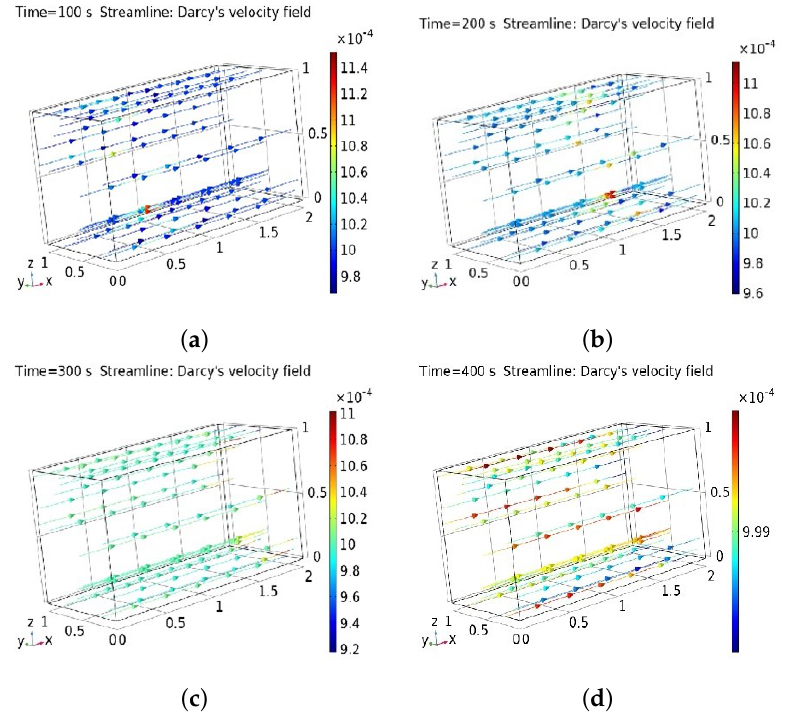
Figure 13. Darcy’s velocity of NF inside the PM at ( a ) 100 s, ( b ) 200 s, ( c ) 300 s, and ( d ) 400